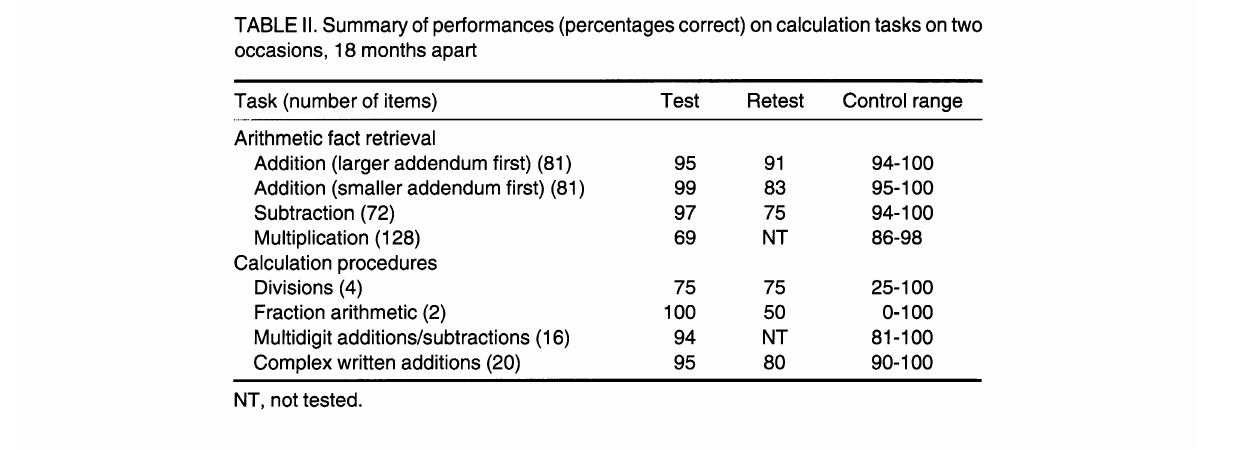
TABLE II. Summary of performances (percentages correct) on calculation tasks on